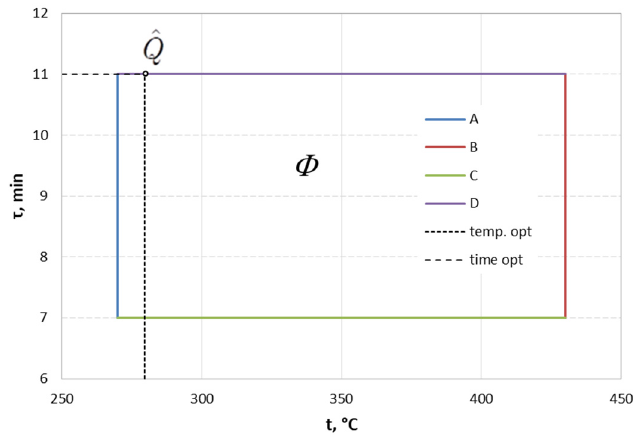
Figure 7. Set of acceptable HT parameters.